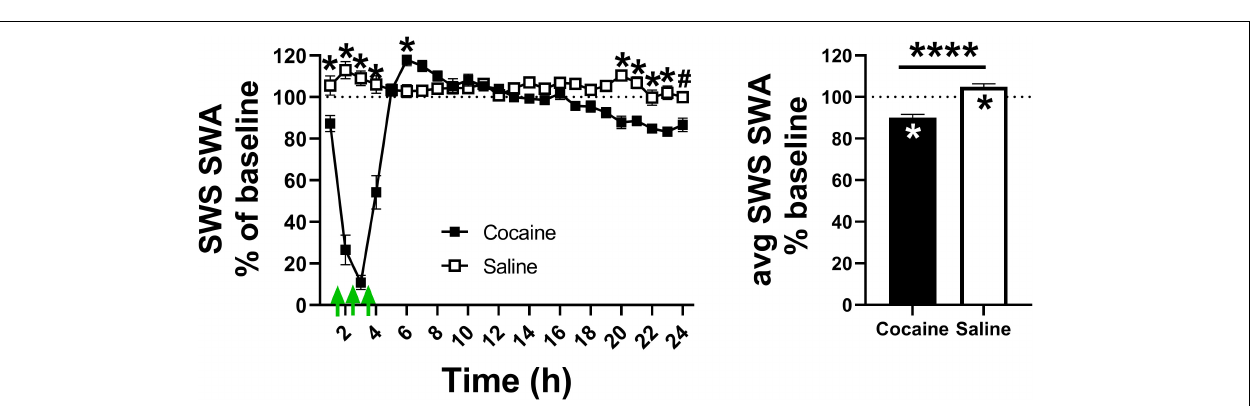
FIGURE 4 | saline decreased waking time and increased SWS time during the middle of the dark phase while REM time was decreased during the injection bin with rebound increase during the middle of the dark phase. Cocaine n = 10, saline n = 9. Asterisks indicate a significant difference within (left, right columns) or between (middle column) groups for specific 4 h bins. The yellow bar indicates the light phase. ( D , top) Transitions between states decreased in cocaine-treated animals during the cocaine exposure period and early part of the light phase (6 h encompassing last 4 h of the dark phase and first 2 h of the light phase) with the exception of SWS to waking transitions that remained similar to baseline levels and to saline (cocaine n = 10, saline n = 9). ( D , bottom) During the remaining portion of the 24 h period (ZT3–ZT20), transitions in cocaine-exposed animals were non-significantly different from baseline (waking to SWS, SWS to REM, REM to waking) and saline (SWS to waking), while state transitions in saline-exposed animals (SWS to REM, SWS to waking, REM to waking, REM to SWS) were significantly different from baseline. ( E , top) Waking duration significantly increased in cocaine-exposed during the cocaine exposure period and early part of the light phase (ZT 21–24, ZT 0–2) compared to baseline and compared to saline (cocaine n = 10, saline n = 9). ( E , bottom) During the remaining period of the 24 h period (ZT 3–20), waking was significantly shorter in cocaine-exposed animals compared to baseline and saline, while REM was significantly longer, and SWS was non-significantly longer compared to baseline. The dashed line at 100 indicates baseline level. Asterisks and pound symbols above lines indicate a significant and non-significant trend toward a difference between groups, respectively, at those states, asterisks and pipes within bars indicate a within-group significant and non-significant trend toward a difference from baseline, respectively. P and F values and statistics for all pairwise comparisons with significant difference or trends toward significance are given in Supplementary Table 2 .